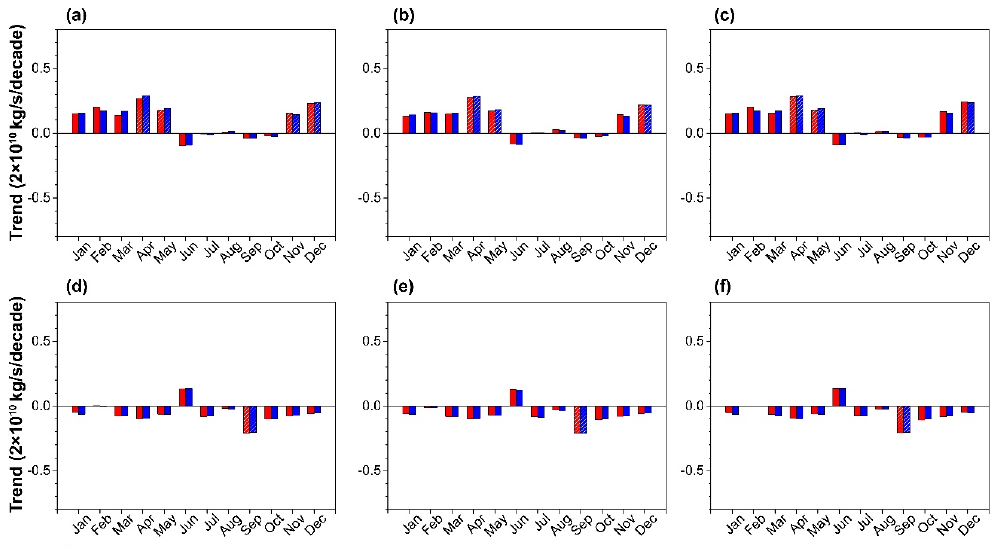
Figure 12. ( a – c ) Annual cycle of the linear trends of the NH HCI from 1979–2018 derived from ( a ) M1, ( b ) M2, and ( c ) M3 using the MRM data sets. The trends that passed the 95% statistical confidence level are filled with oblique lines. The red and blue bars are for the results that considered and did not consider FBGMW, respectively. ( d – f ) Same as ( a – c ) but for the SH HCI. The units for the trends are 2 × 10 10 kg/s/decade.